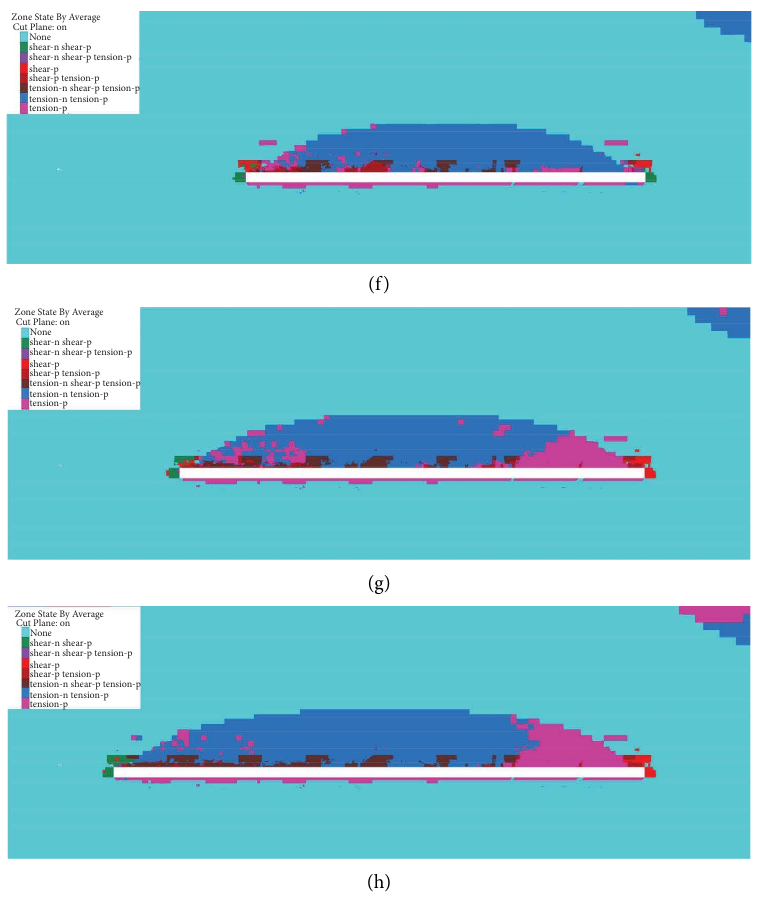
Figure 8: Fracture height of overlying rock revealed by numerical simulation. (a) Caving 50m. (b) Caving 100 m. (c) Caving 150 m. (d) Caving 200m. (e) Caving 250m. (f) Caving 300m. (g) Caving 350m. (h) Caving 400m.